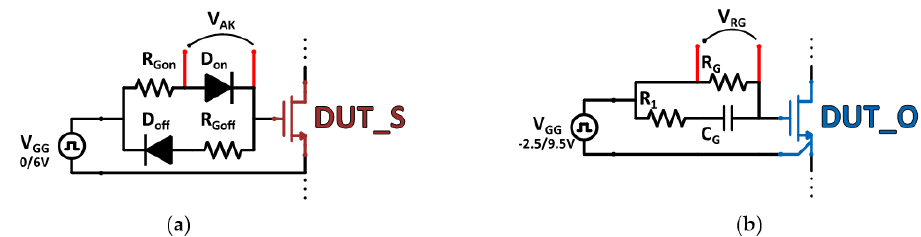
Figure 7. Typical gate driver networks for ( a ) Schottky − gate and ( b ) Ohmic − gate GaN HEMTs.